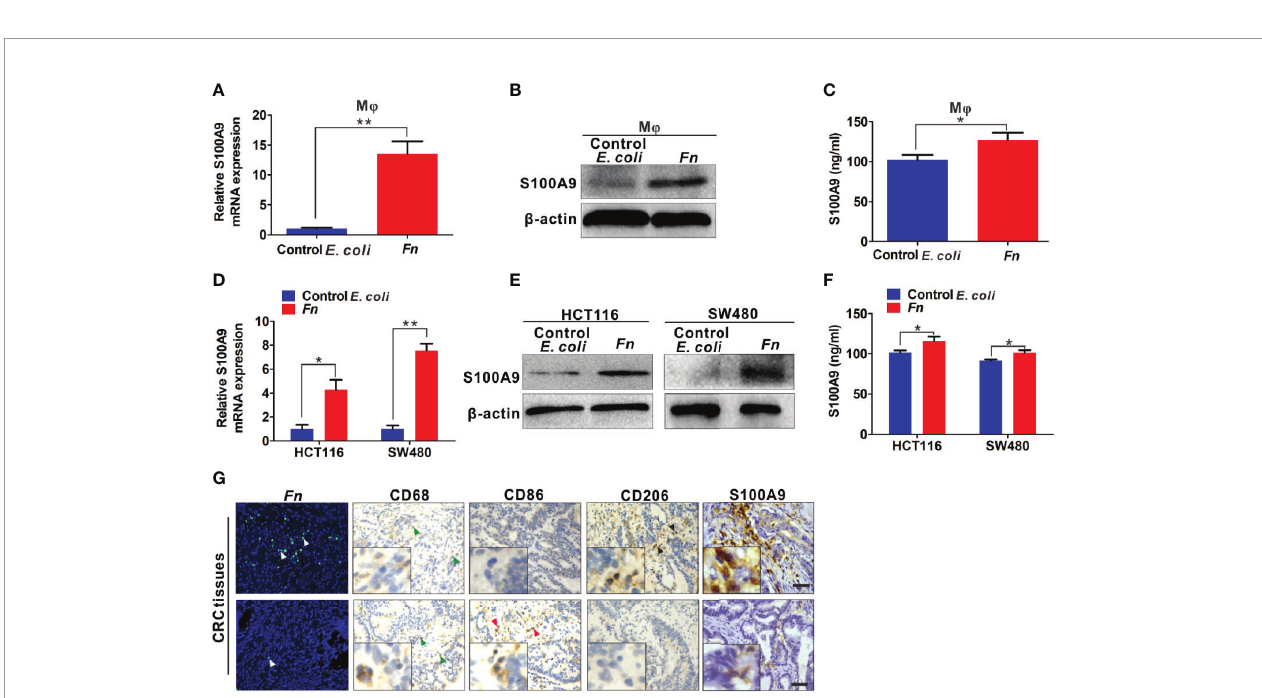
FIGURE 2 | S100A9 expression is up-regulated in Fn -challenged M j and CRC cells. (A – F) M j and CRC cells were co-cultured with control E. coli or Fn . S100A9 levels were detected by qPCR (A, D) , Western blot (B, E) and ELISA (C, F) . (G) Representative images of CD68 + M j , CD86 + M j , CD206 + M j , and S100A9 expression in the TME of Fn -positive CRC tissues. White arrow: Fn ; blue arrow: CD68 + M j ; red arrow: CD86 + M j ; black arrow: CD206 + M j . Scale bars: 50 µm. Data were expressed as means ± SD in three independent experiments. *p < 0.05, **p <